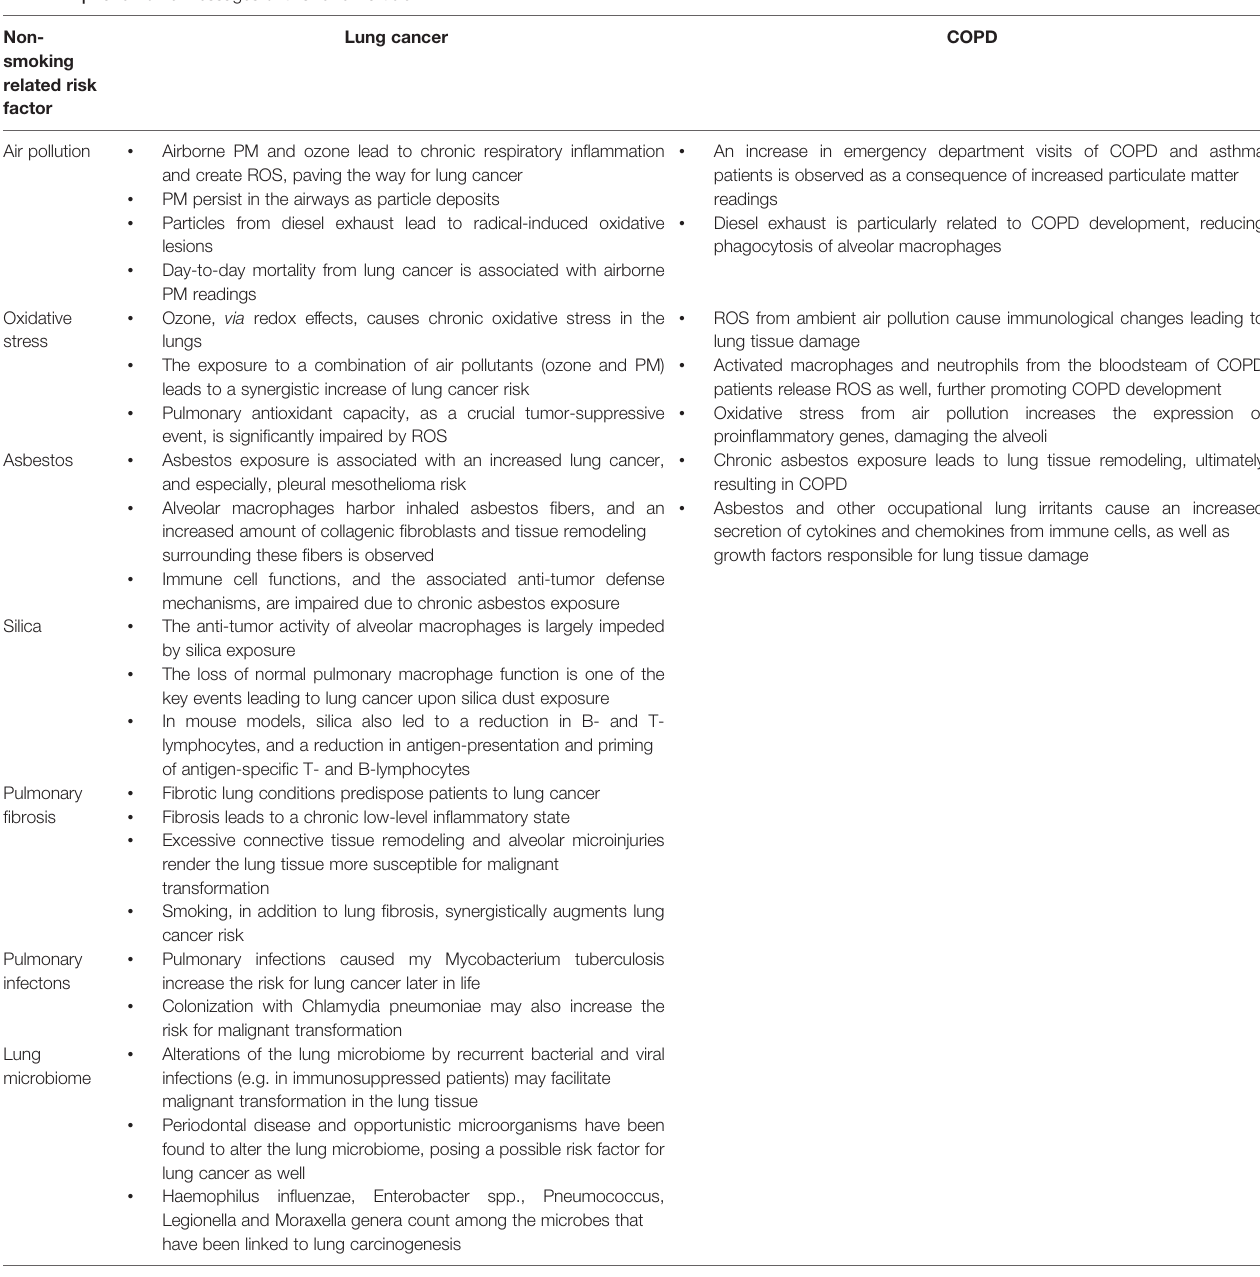
TABLE 2 | Take-home messages of this review